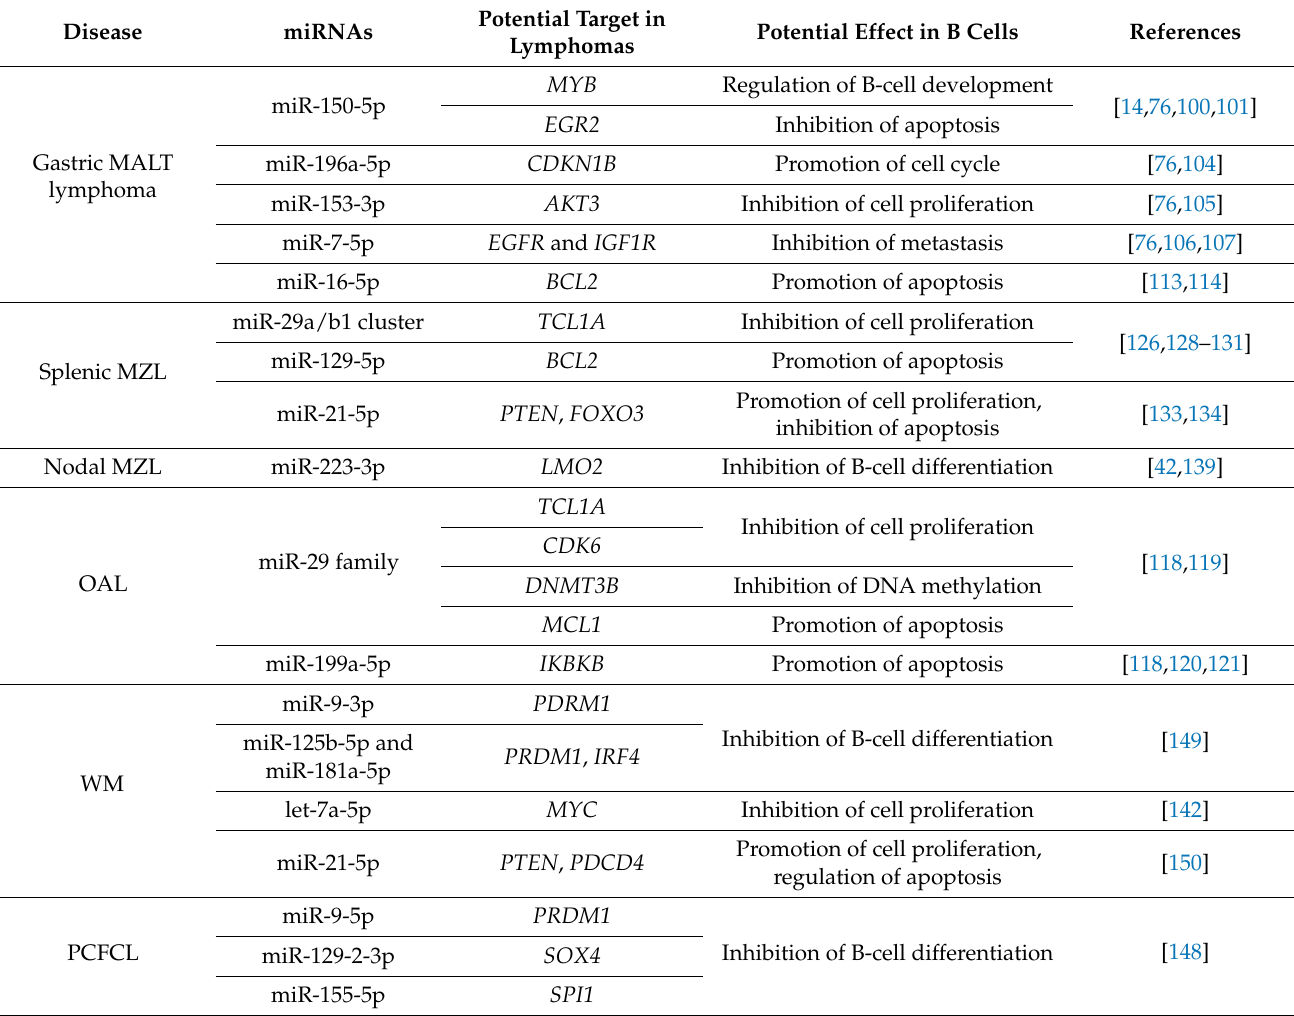
Table 5. Potential interactions between miRNAs that are deregulated in indolent B-cell NHLs and their validated targets in other malignancies. Disease miRNAs